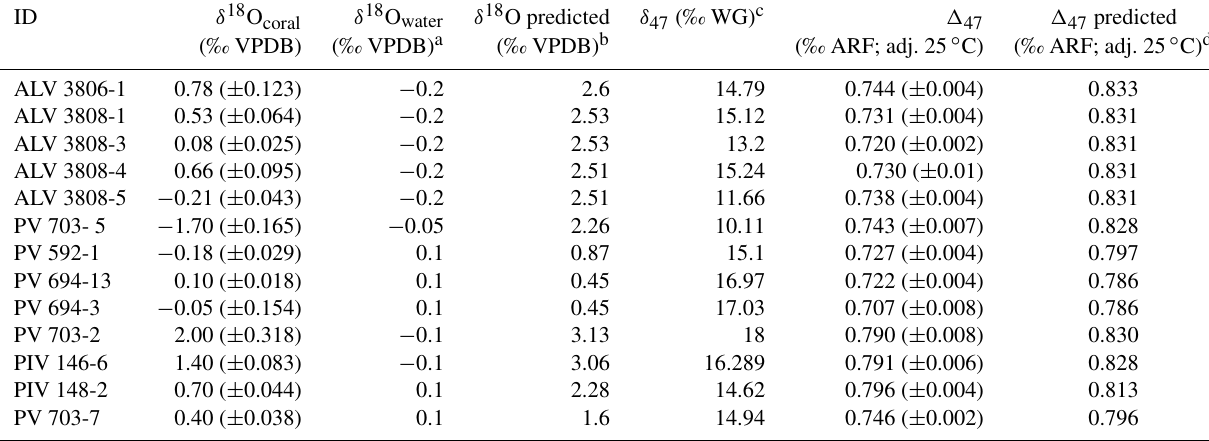
Table 4. Coral specimens analyzed for δ 13 C, δ 18 O, and (cid:49) 47 . Average (cid:49) 47 for all replicate measurements is reported relative to the absolute reference frame (ARF). δ 47 is reported relative to intra-laboratory working gas